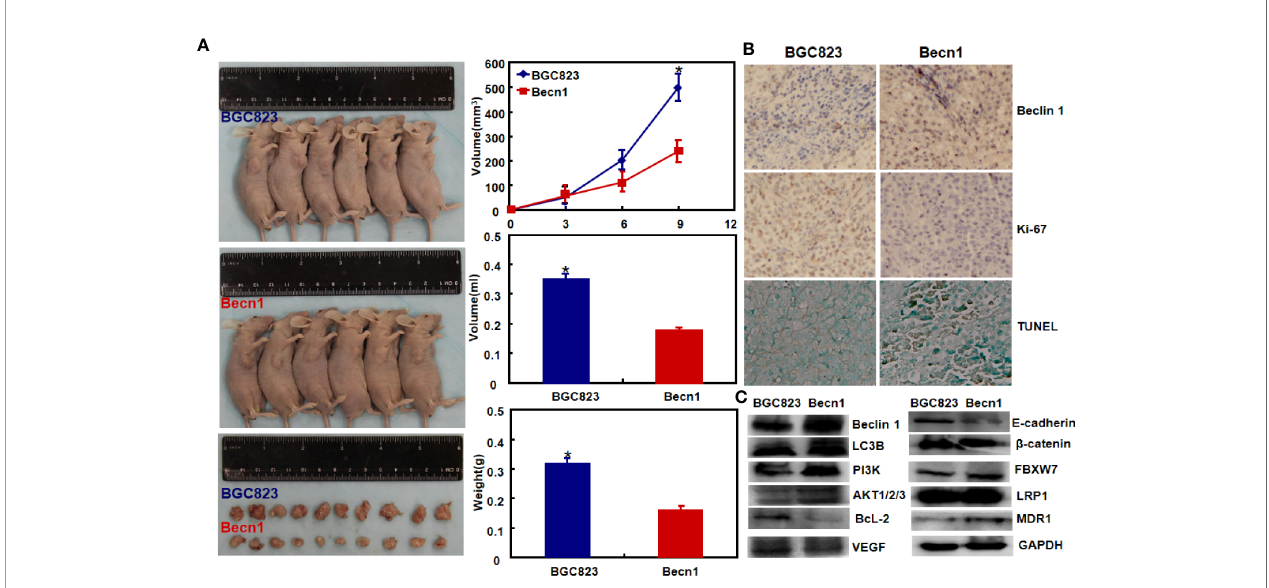
FIGURE 3 | The effects of Becn1 expression on tumor growth of gastric cancer. The growth of gastric cancer cells was faster and heavier than their Becn1 transfectants by gross appearance, and measuring tumor volume and weight [ (A) , P < 0.05]. The transfectant cells showed stronger signals of Beclin 1 and apoptosis than the control in subcutaneous tumor, but versa for ki-67 immunoreactivity (B) . The phenotype-related proteins were screened using xenograft tumor tissues by Western blot (C) . * P < 0.05, compared with the transfectant.